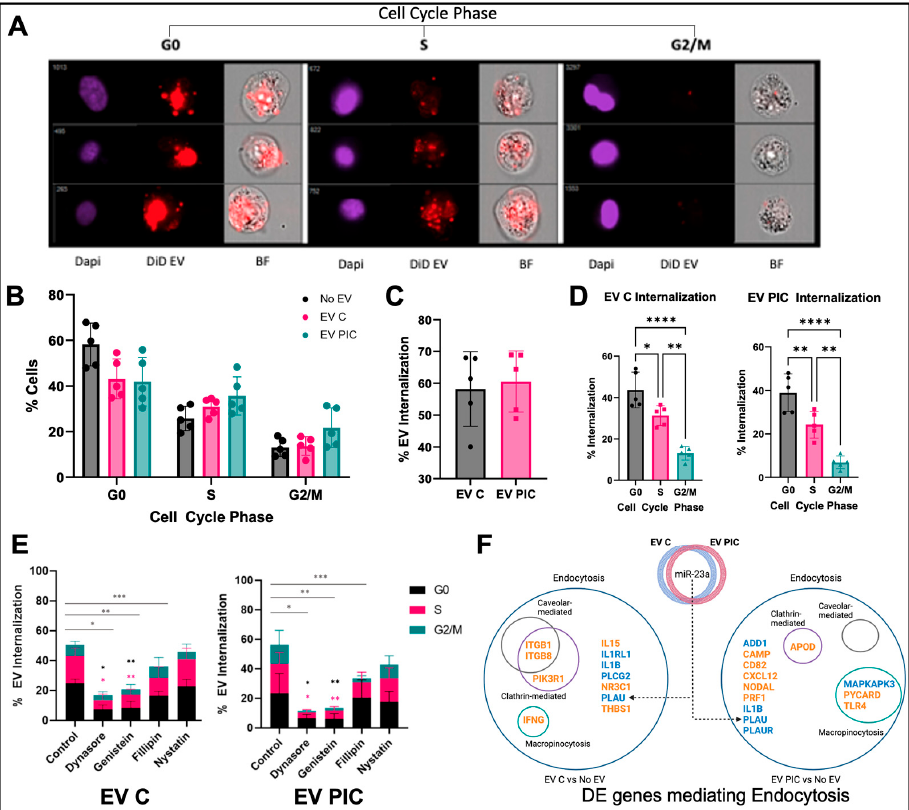
Figure 1. PC3ML EV internalization is cell cycle-dependent and independent of vesicle type. EV uptake and cell cycle phase was assessed using Amnis ImageStream. Representative images showing EV internalization (red), nuclei (blue), and phase contrast of cells in different cell cycle phases ( A ). The proportion of cells at each cell cycle phase did not change with EV C or EV PIC treatment relative to untreated control ( B ). Percent EV internalization was not different between EV C and EV PIC, n = 5 biological replicates, p = 0.7396 ( C ). Quantification of the proportion of EV internalization at each cell cycle phase in EV-treated cells revealed that the majority of internalization occurred at G0, followed by S phase, with the fewest vesicles being internalized at G2/M (EV C, n = 5, **** p < 0.001, * p = 0.0183, ** p = 0.0012; EV PIC, n = 5, **** p < 0.0001, * p = 0.0085, ** p = 0.00027) ( D ). PC3MLs were incubated with endocytosis inhibitors dynasore, genistein, fillipin, or nystatin during vesicle treatment. In both EV C and EV PIC treated cells, EV internalization was significantly reduced by treatment with dynasore (EV C, n = 5, * p = 0.0001; EV PIC, n = 5, * p < 0.0001), genistein (EV C, n = 5, ** p = 0.0004; EV PIC, n = 5, ** p < 0.0001), and fillipin (EV C, n = 5, *** p = 0.021; EV PIC, n = 5, *** p = 0.0053). dynasore and genistein significantly reduced the proportion of EV internalized at G0 (EV C, n = 5, * p < 0.0001, ** p < 0.0001; EV PIC, n = 5, * p = 0.0017, ** p = 0.0012) and S phase (EV C, n = 5, * p = 0.0008, ** p = 0.012; EV PIC, n = 5, * p = 0.0059, ** p = 0.0153). Asterisks in black and pink directly above dynasore and genistein bars indicate significant differences in cell cycle phase proportion ( E ). Differential expression analysis of cells treated with EV C vs. control and cells treated with EV PIC vs. control showed deregulation of genes mediating multiple mechanisms of endocytosis ( F ). Genes in blue are downregulated, and genes in orange are